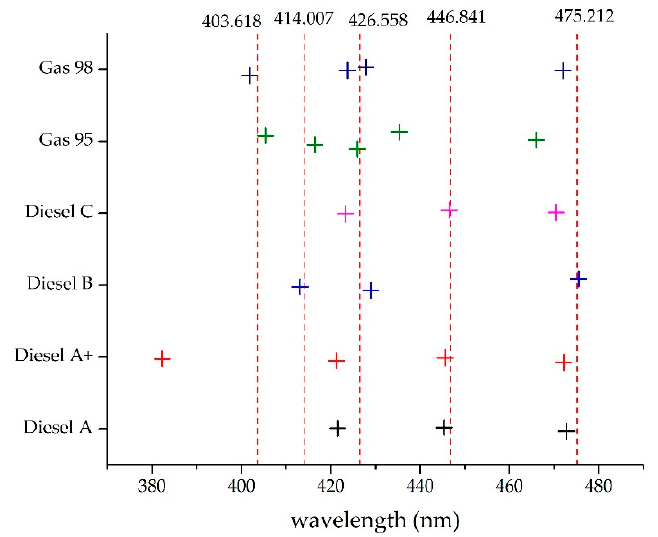
Figure 11. Determination of wavelengths to be used in the common template.